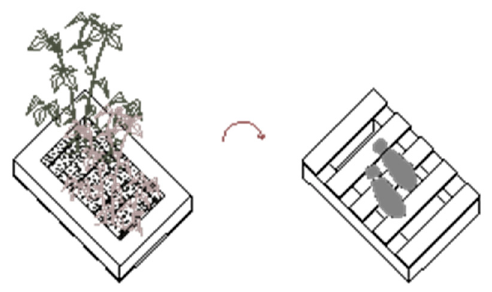
Figure 7. The double use of the pallets [12].